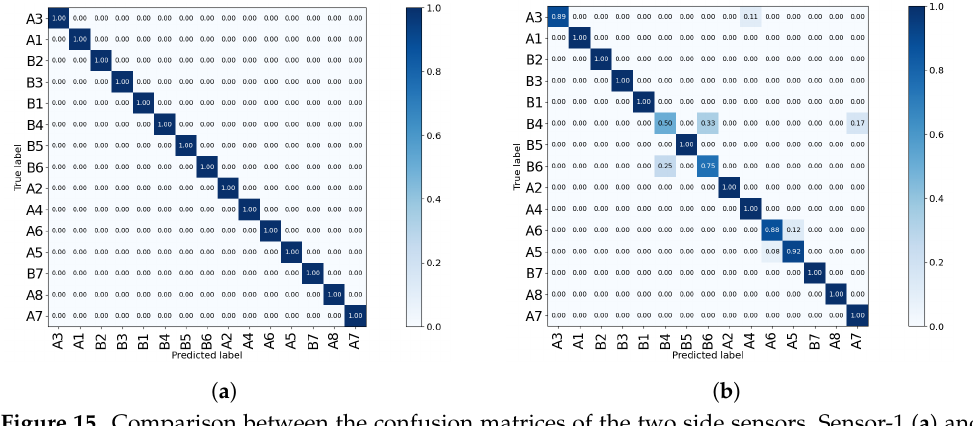
Figure 15. Comparison between the confusion matrices of the two side sensors, Sensor-1 ( a ) and Sensor-3 ( b ) of the Coventry-2018 dataset. The large layout with single- and double-subject data was used for training a model based on SVD and LR.